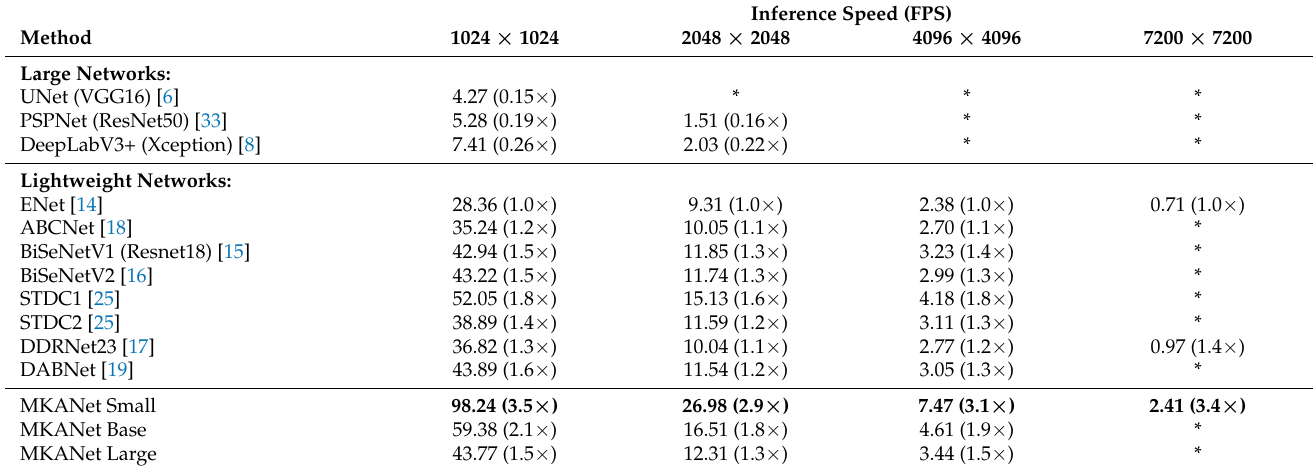
Table 3. Inference speed at 4 image sizes; the number of classes was